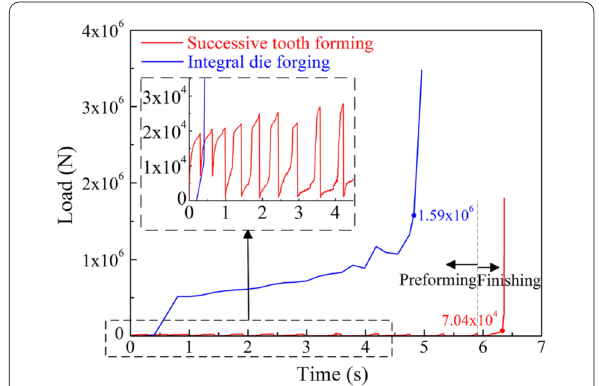
Figure 11 The load of successive tooth forming and integral die forging